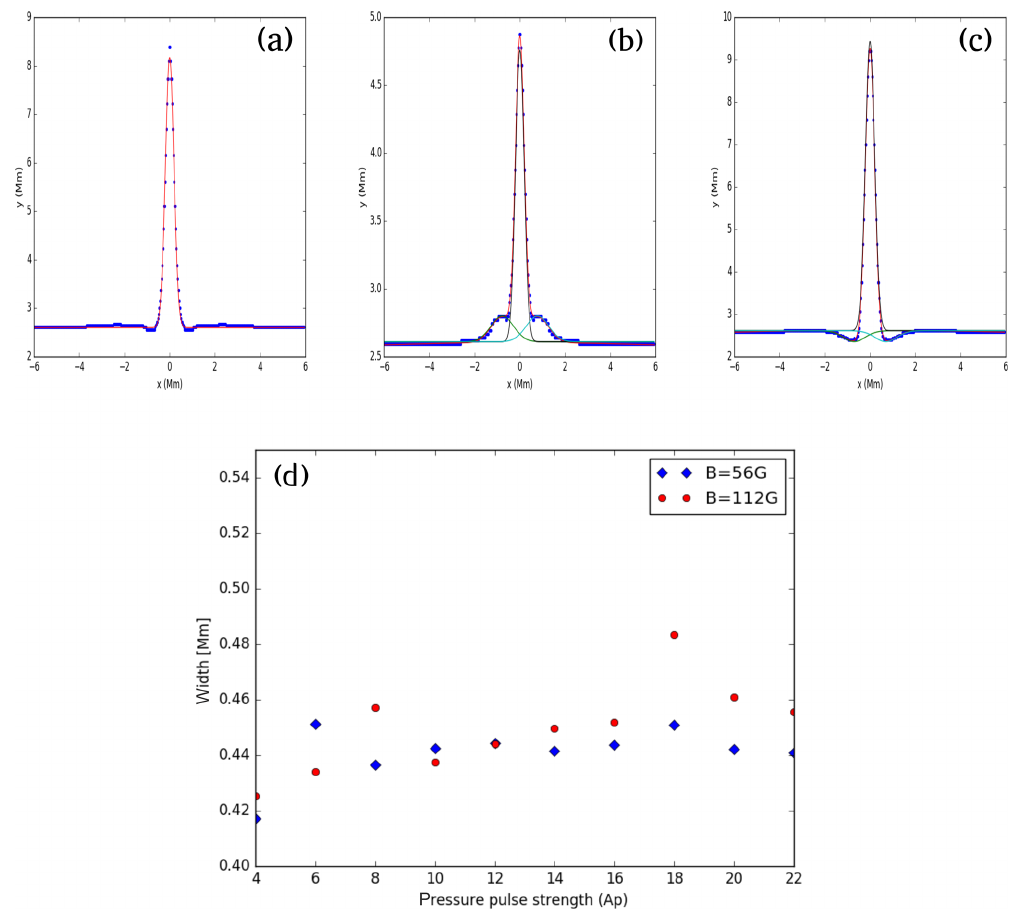
Figure 10. (a, b, c) The example spatial profiles of various jets when they reach their respective maximum height. Panels (a) , (b) , and (c) show spatial profiles of the jet at B = 56 gauss and A p = 16, B = 56 gauss and A p = 6, and B = 112 gauss and A p = 18 respectively. As the base of these jets exhibits a complex shape, the triple or single Gaussian profiles are fitted and the respective full width half maximums (FWHMs) are estimated after determining the Gaussian width. (d) The width of the jets vs. the pressure pulse strength ( A p ) in the solar atmosphere for the B = 56 gauss (blue diamonds) and B = 112 gauss (red circles) magnetic fields. The FWHMs of various jets lie between 0.42 and 0.48Mm. They show a mild increasing trend for both of the magnetic